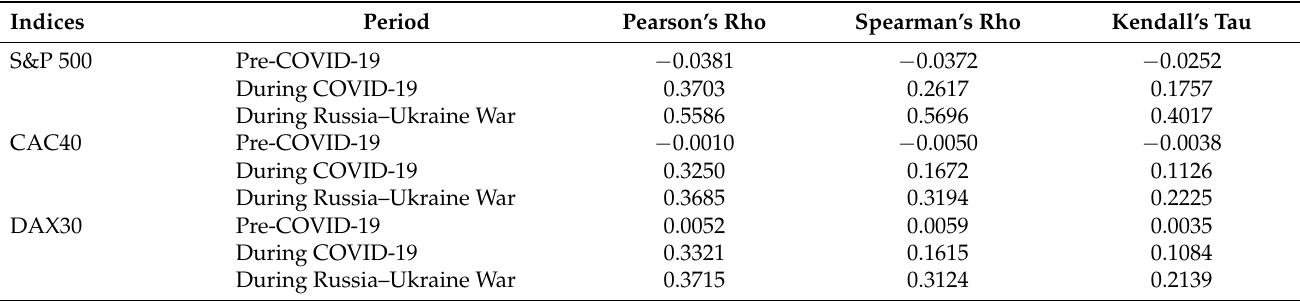
Table 2. Static Correlations for a Bitcoin-G7 indices portfolio.